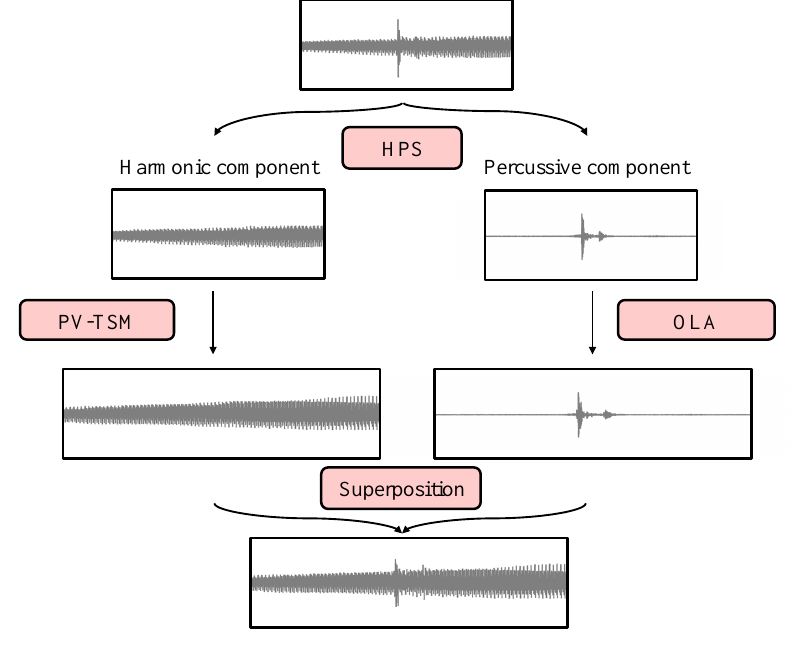
Figure 11. Principle of TSM based on harmonic-percussive